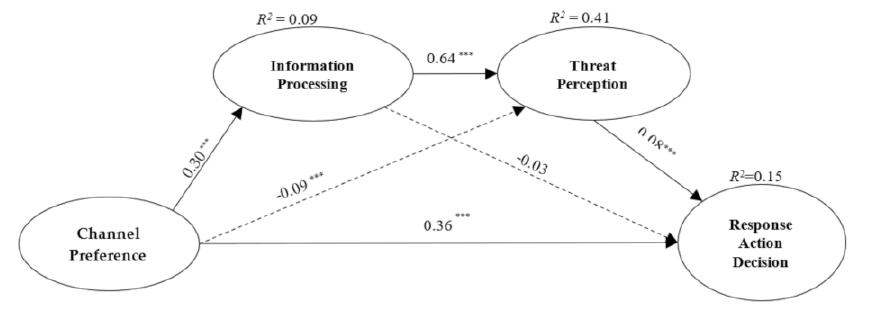
Figure 3. Schematic diagram of multi-stage correction model. Note: *** represents p < 0.001, the dash line indicates that there is no effective link between the two